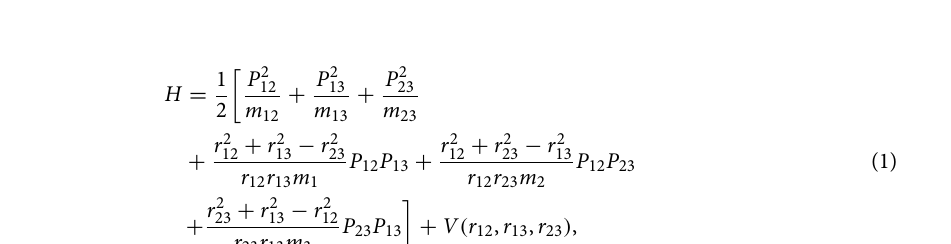
Figure 1. The three-body harmonic oscillator (TBHO) in R d ( d > 1 ) with finite rest lengths. The configuration of equilibrium occurs when the distances between the bodies equal the rest lengths, r ij = R ij , and the bodies are at